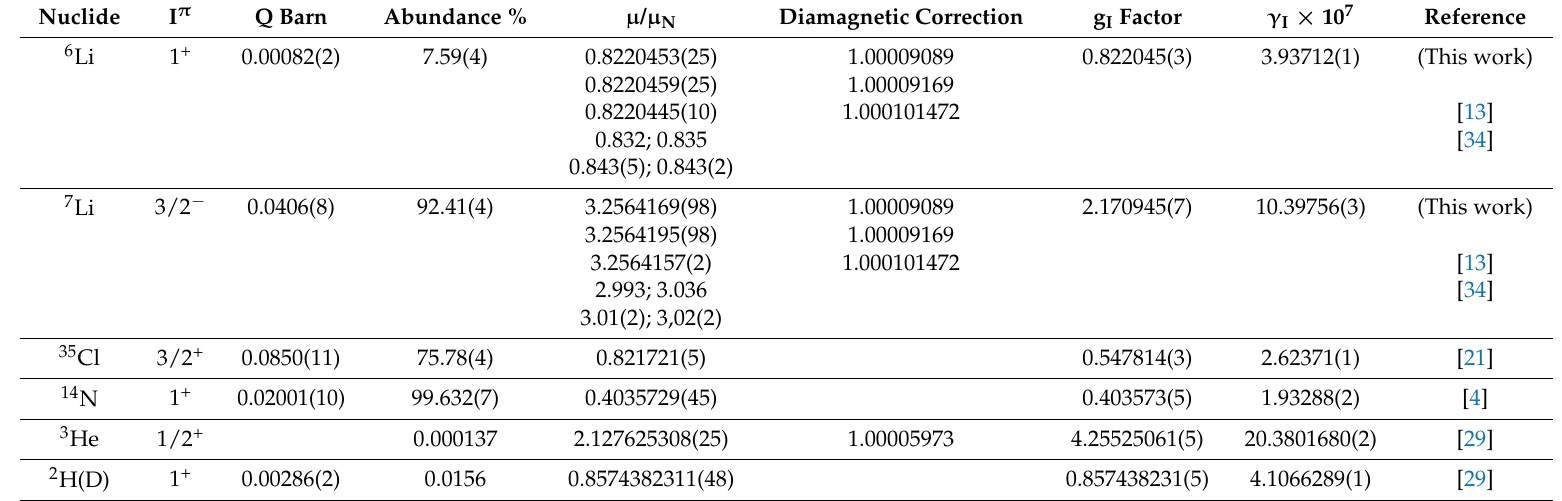
Table 3. Electromagnetic properties of lithium, chlorine, nitrogen, helium and deuterium